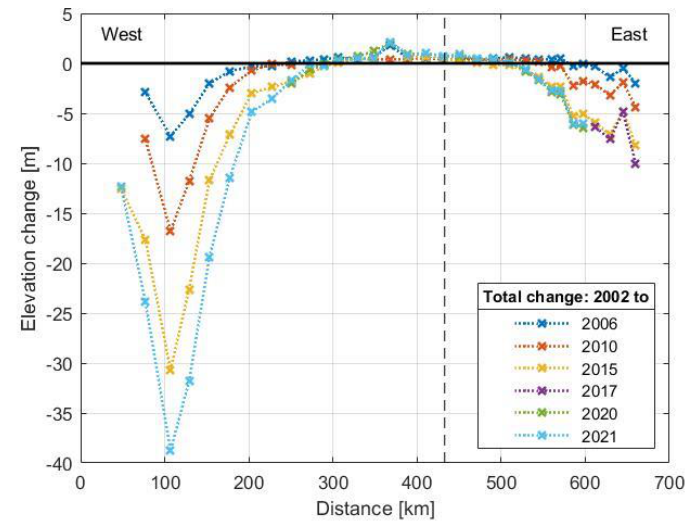
Figure 6. Total elevation changes in the camps from 2002.